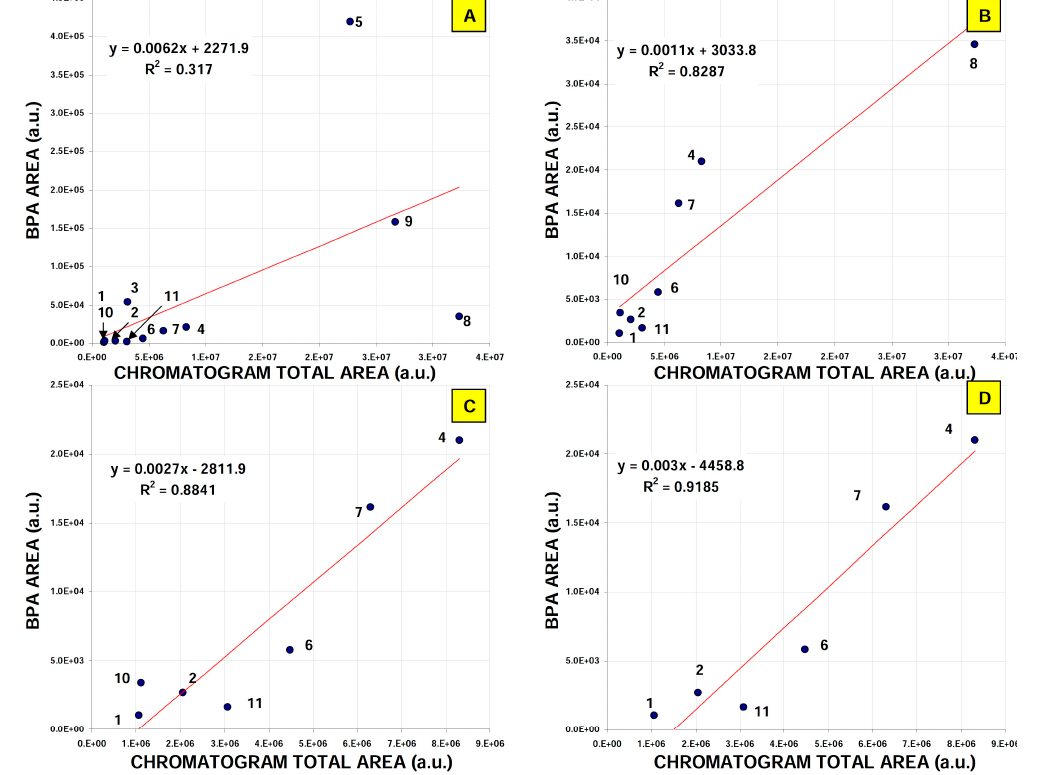
Figure 6. Correlation observed between SPE extracts contents (the total peaks area on UV-DAD chromatograms) and the bisphenol A peak area for each extracted material. Sample labelling: ( A ). all tested materials; ( B ). without samples 3, 5 and 9; ( C ).without samples 3, 5, 9 and 8; ( D ). without samples 3, 5, 9, 8 and 10. Dots numbers corresponds to material types listed in Tables 5 and